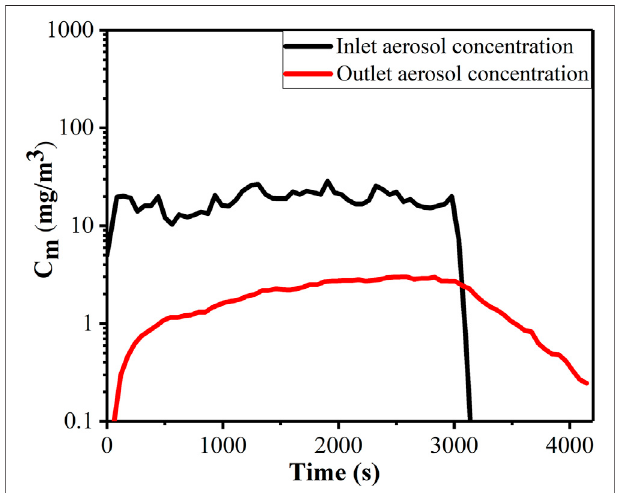
FIGURE 7 | The effect of particle diameter on DF in SF1.